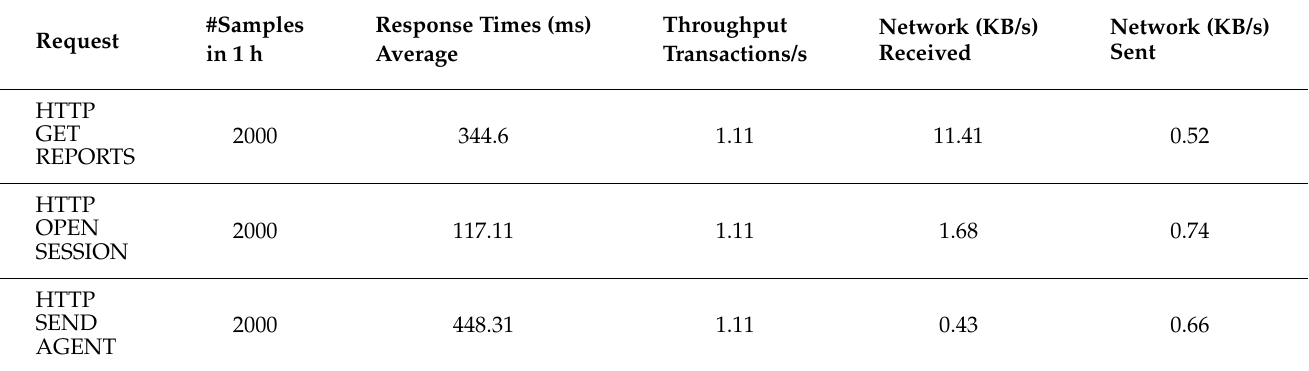
Table 7. Performance evaluation for assigning an intervention to an